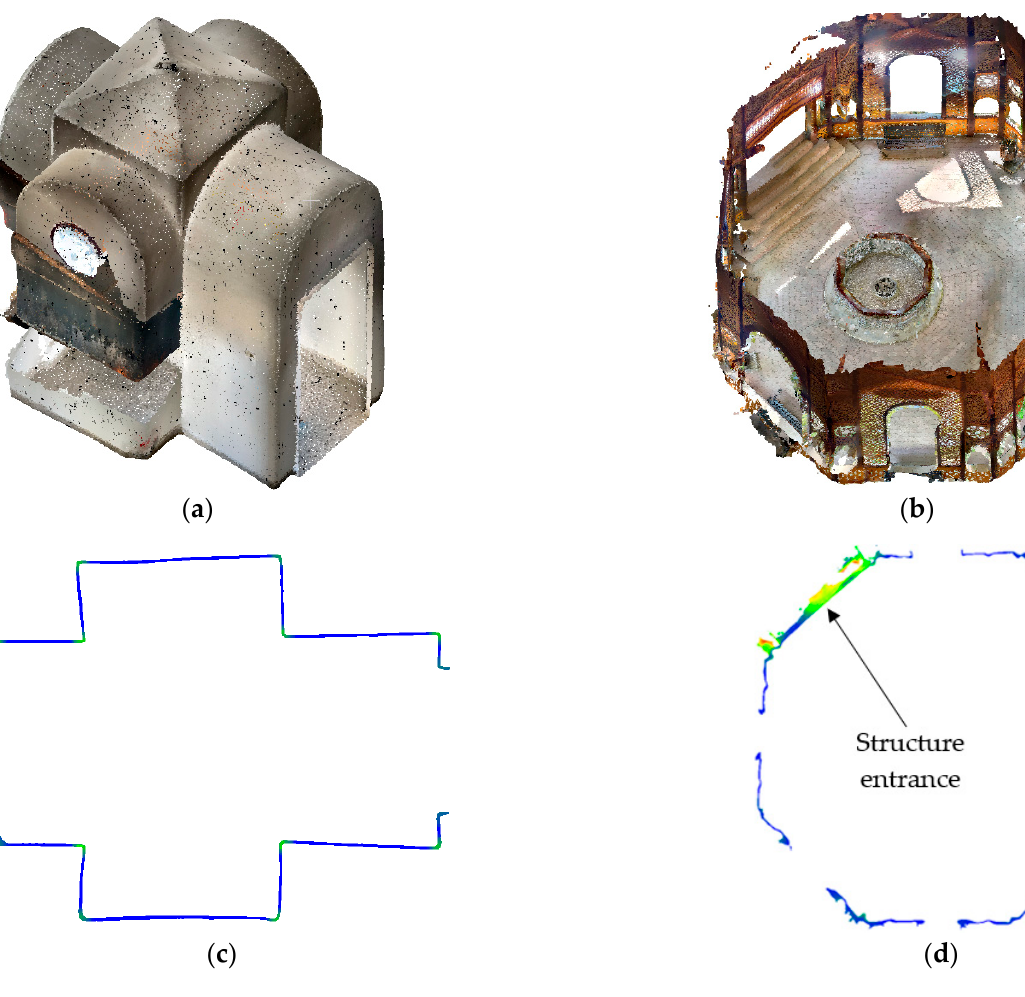
Figure 16. Scans of two structures collected for documentary purposes; scalar field refers to the surface variation value: first structure ( a ), second structure ( b ), section of first structure ( c ), section of second structure ( d ).